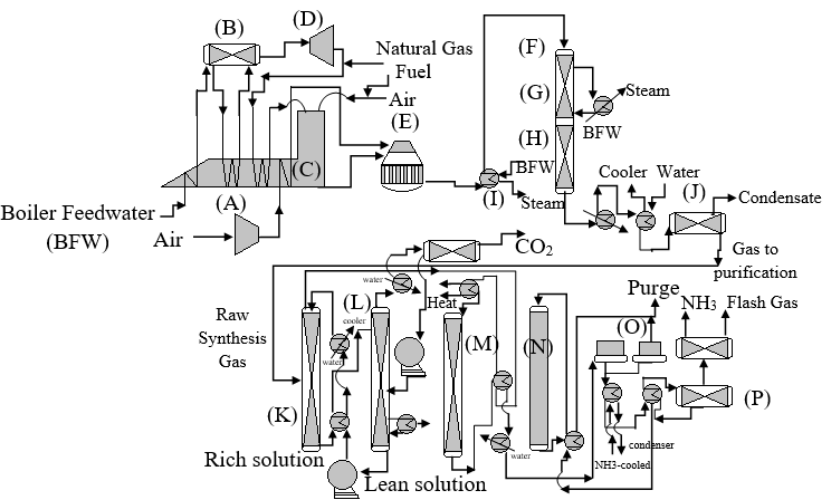
Figure 7. KBR design of the first single-train (large-capacity ammonia plant (A) Compressor, heat recovery section (B) Steam Drum (D) Power turbine (E) Secondary reformer (F) CO convertor (G) First stage high-temperature synthesis (H) Second stage low-temperature synthesis (I) BFW heat recovery (J) Condensation (K) CO 2 absorber (L) CO 2 stripper (M) Methanator (N) NH 3 Converter (O) Compression (P) Separator, reproduced from References